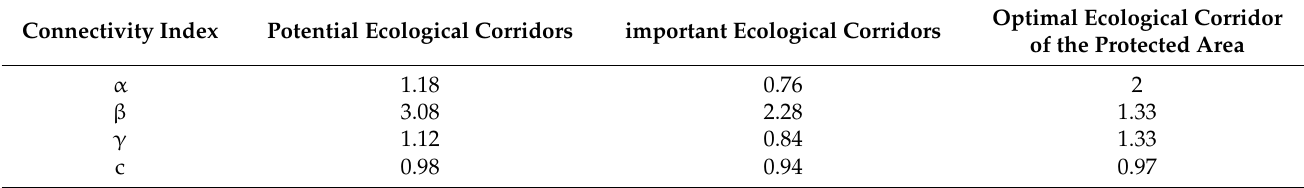
Table 6. Ecological corridor connectivity evaluation